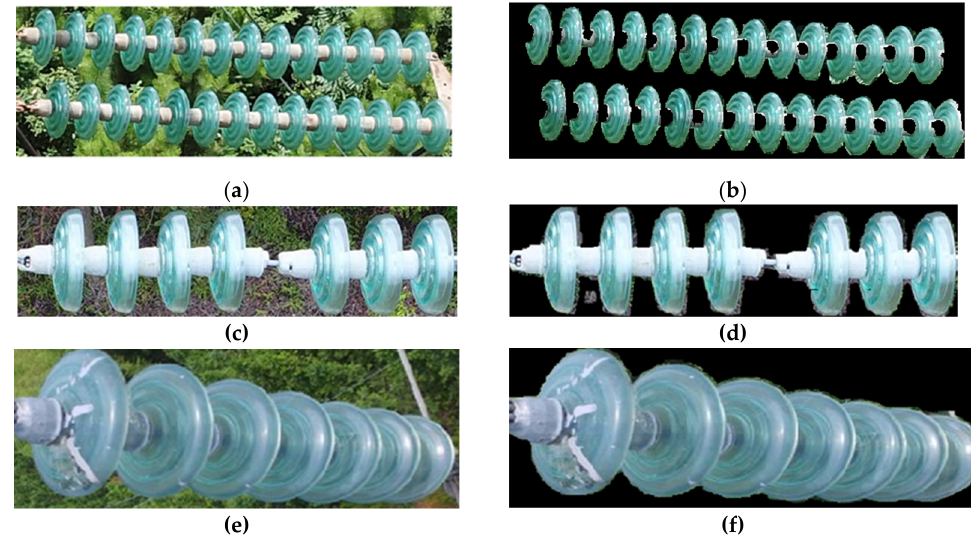
Figure 6. The process of removing the background from the insulator image. ( a , c , e ) are the insulator target images, and ( b , d , f ) are their corresponding segmented images.